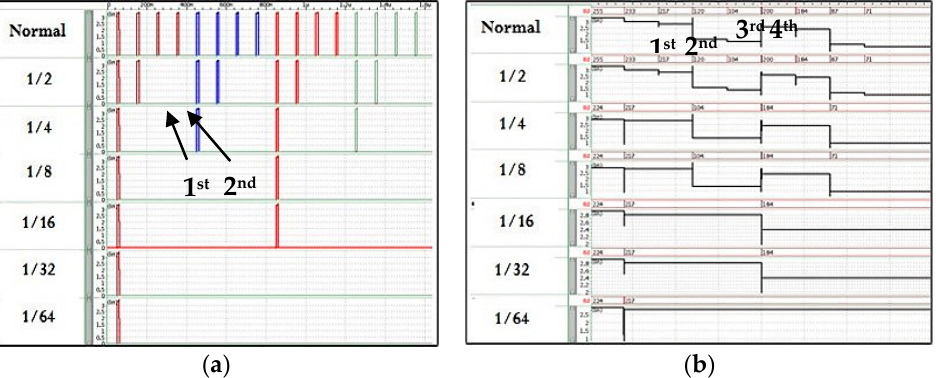
Figure 8. Simulation results showing ( a ) row control signals and ( b ) pixel output voltage (V IN ) for the input of column ADC array with different resolutions.